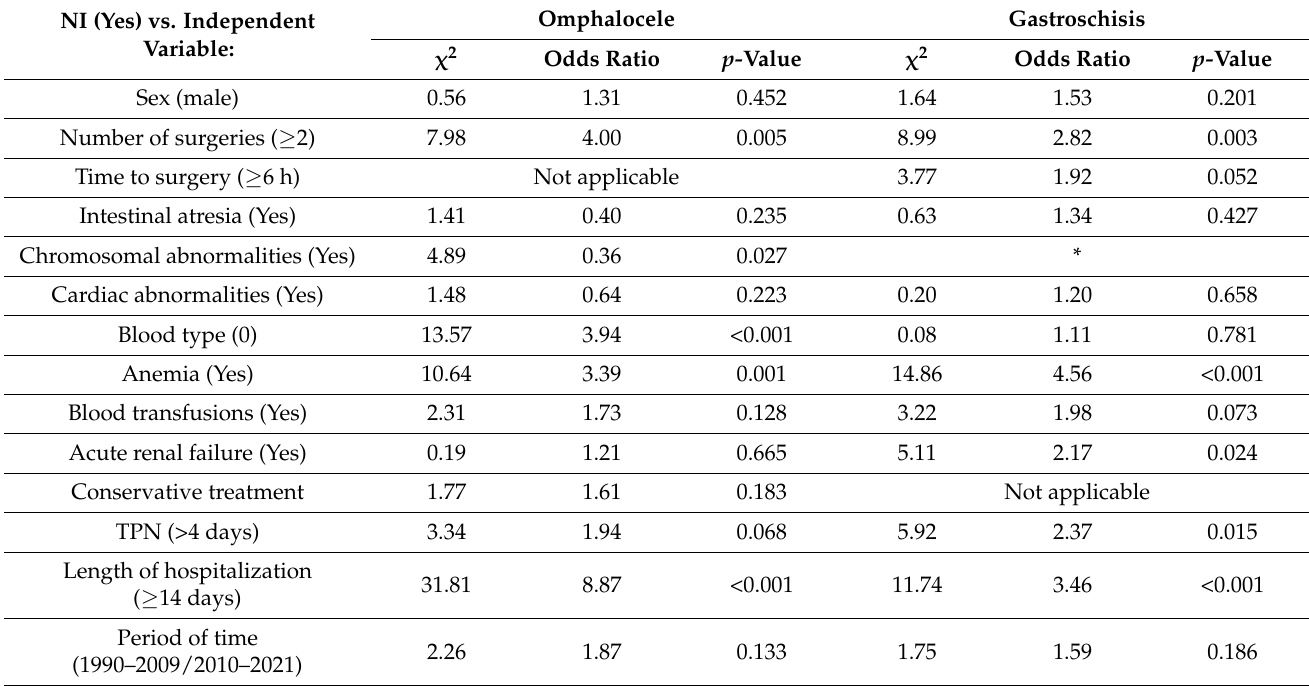
Table 3. Univariate analysis regarding the assessment of the association between the occurrence of NI and the analyzed risk factors.